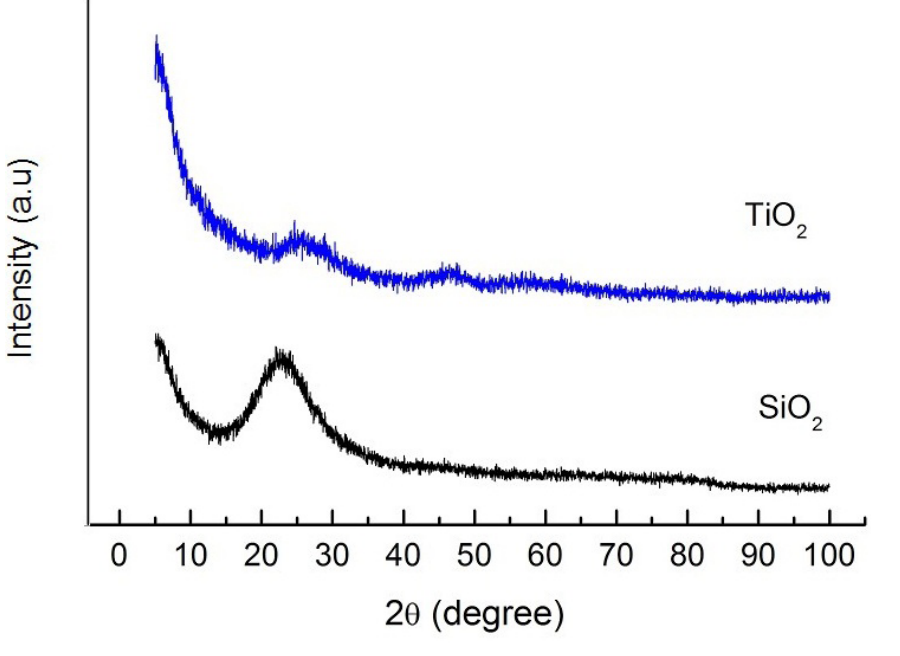
Figure 1: The diffractogram of prepared TiO2 and SiO2.